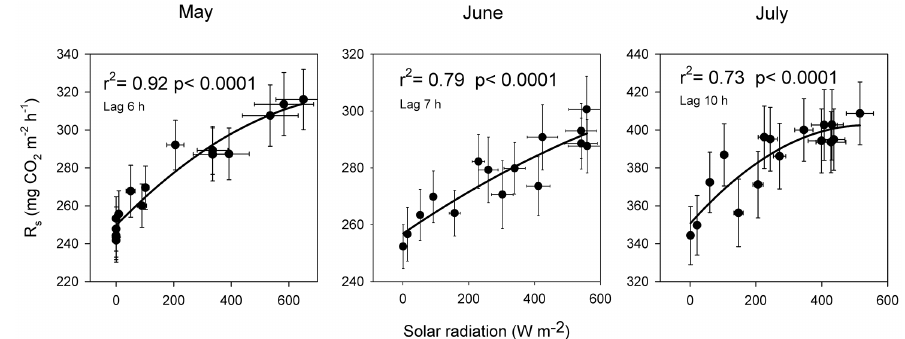
Figure 5. Response of R s to preceding levels of solar radiation in Miscanthus outside of the typical manual measurement window (see text). Values shown are hourly means ( ± 1SE, n = 6) averaged over each month. The lag time is the length of the offset between the measured solar radiation and the R s ; for example, for May the relationship shown is that of solar radiation at 12:00 and R s measured at 18:00 (lag time = 6h) and the lag times shown for each month are those which yield the closest relationship (highest R 2 )